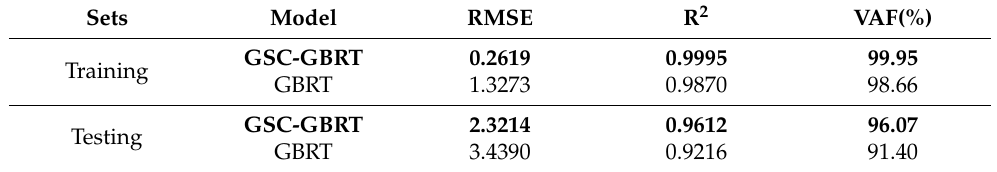
Table 4. GSC-GBRT and GBRT model performance in predicting the Cs for training and test datasets.